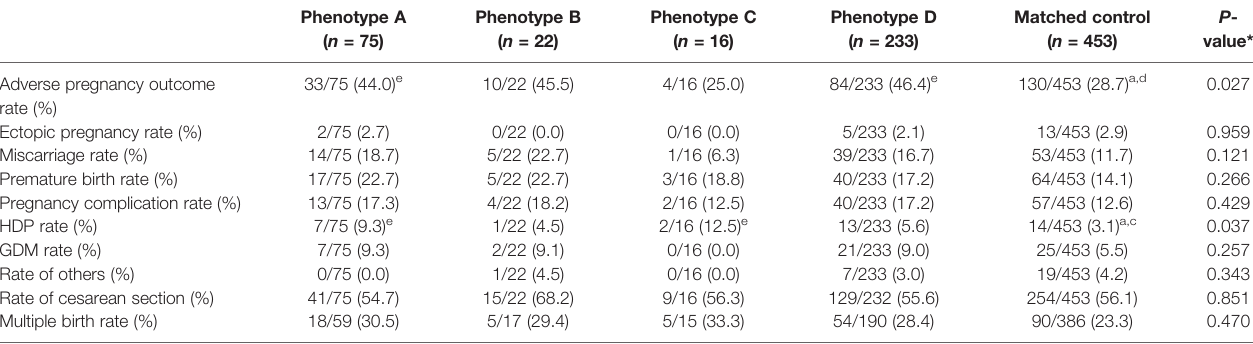
TABLE 3 | Comparison of adverse perinatal outcomes among the four PCOS phenotype groups and the control